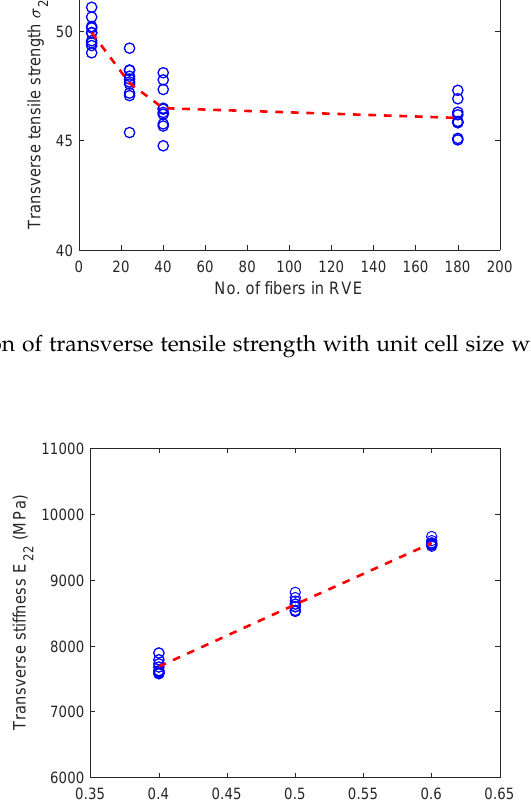
Figure 15. Effect of fiber volume fraction on the transverse stiffness for six-fiber unit cells. (D’Mello and Waas [12]).